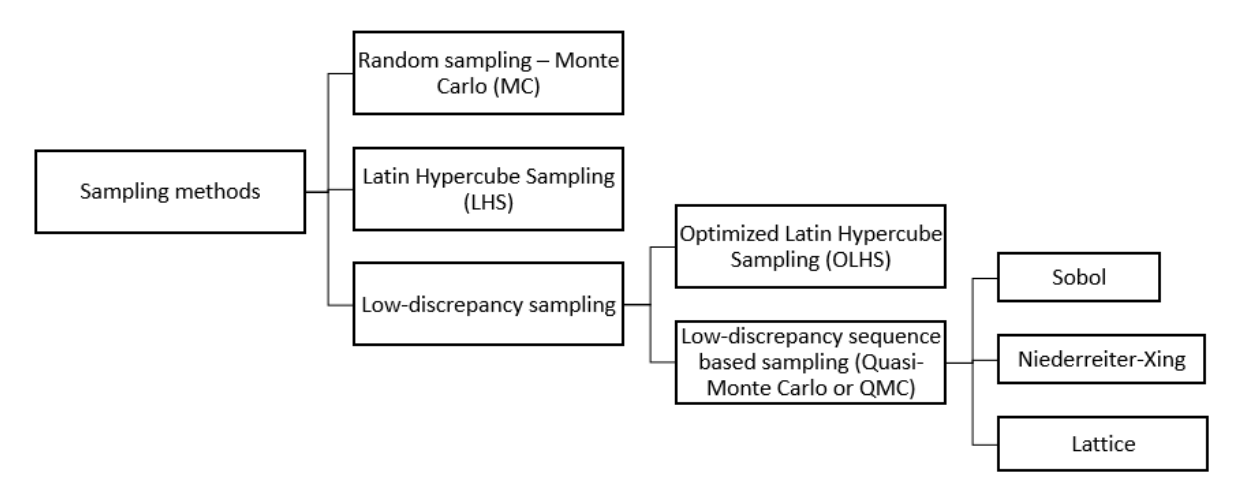
Figure 9. Categorisation of different sampling methods. Note: The sampling points generated by the Quasi-Monte Carlo methods are deterministic points. To allow error estimation, the points from Quasi-Monte Carlo methods have to be randomised. Thus, it is referred to as Randomized Quasi-Monte Carlo (RQMC).